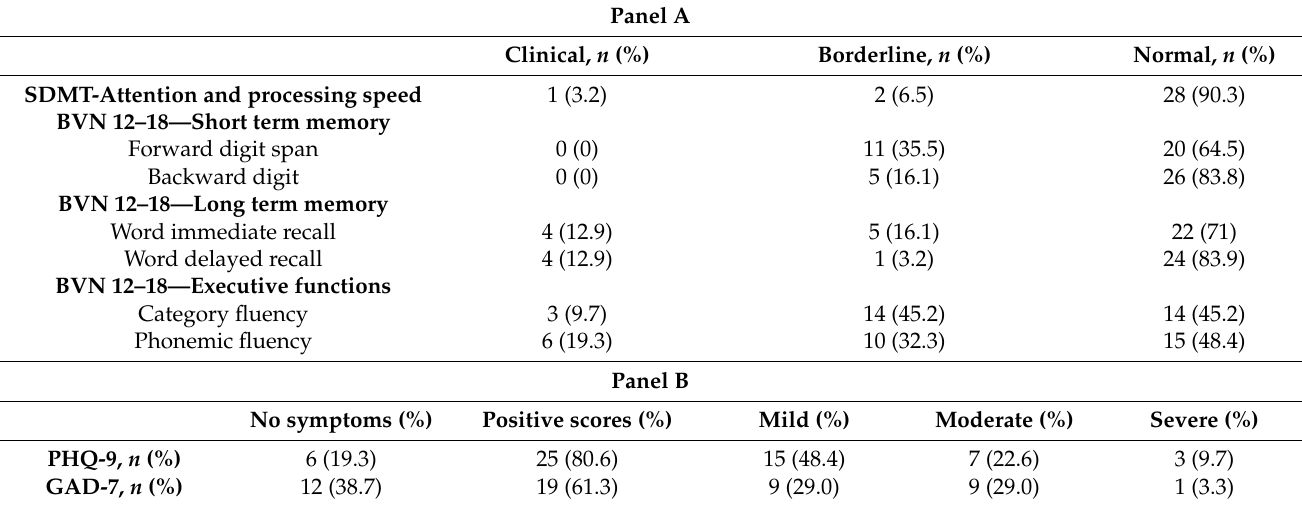
Table 1. Percentage of subjects with neuropsychological difficulties (Panel A) and with depression and anxiety symptoms (Panel B).